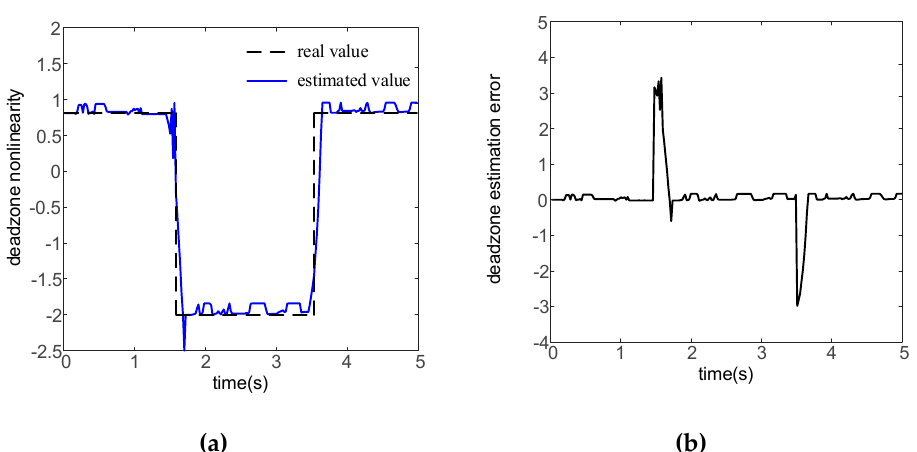
Figure 12. Dead zone non-linearity estimation performance of joint 1 ( a ) and estimation error ( b ).